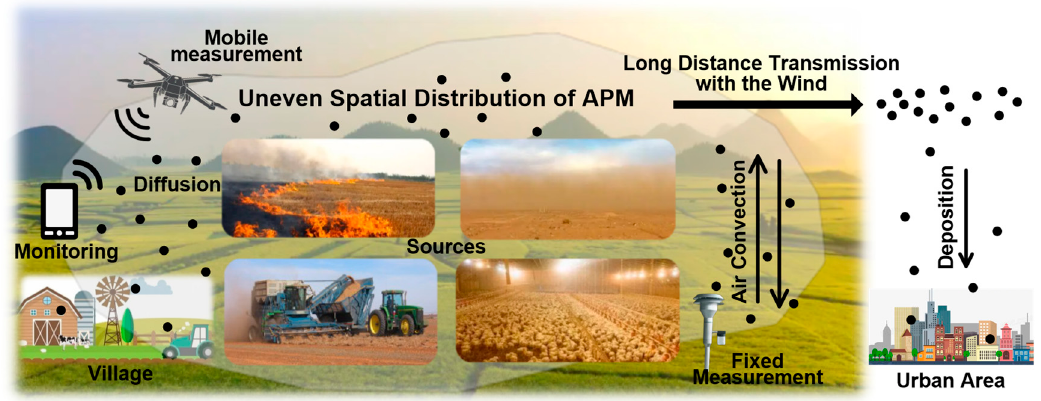
Figure 1. Diffusion, transmission, and measurement of particulate matter from agricultural activities.